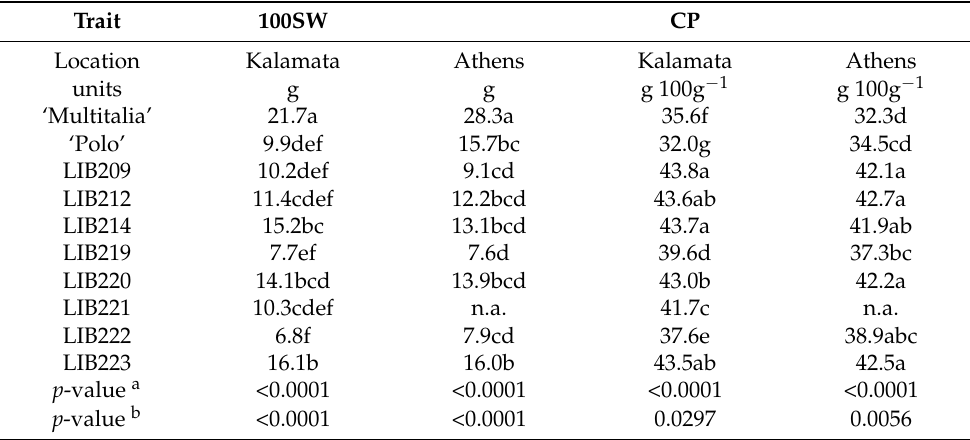
Table 6. Seed weight and quality traits among L. mutabilis accessions and between locations in comparison to white (‘Multitalia’) and narrow-leafed lupin (‘Polo’). Trait 100SW CP Location Kalamata Athens Kalamata Athens units g g g 100g − 1 g 100g − 1 ‘Multitalia’ 21.7a 28.3a 35.6f 32.3d ‘Polo’ 9.9def 15.7bc 32.0g 34.5cd LIB209 10.2def 9.1cd 43.8a 42.1a LIB212 11.4cdef 12.2bcd 43.6ab 42.7a LIB214 15.2bc 13.1bcd 43.7a 41.9ab LIB219 7.7ef 7.6d 39.6d 37.3bc LIB220 14.1bcd 13.9bcd 43.0b 42.2a LIB221 10.3cdef n.a. 41.7c n.a. LIB222 6.8f 7.9cd 37.6e 38.9abc LIB223 16.1b 16.0b 43.5ab 42.5a <0.0001 <0.0001 0.0297